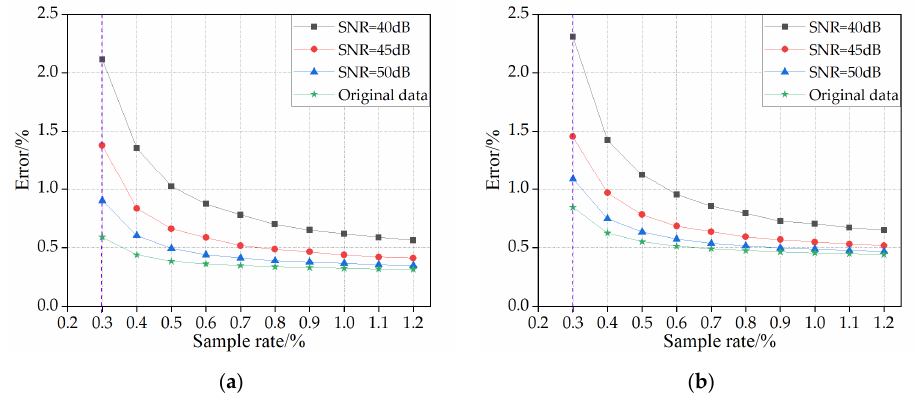
Figure 4. Comparison of reconstruction errors between different sample rates with different noise levels (original measurement data, SNR = 40 dB, SNR = 45 dB, SNR = 50 dB). ( a ) Comparison in test